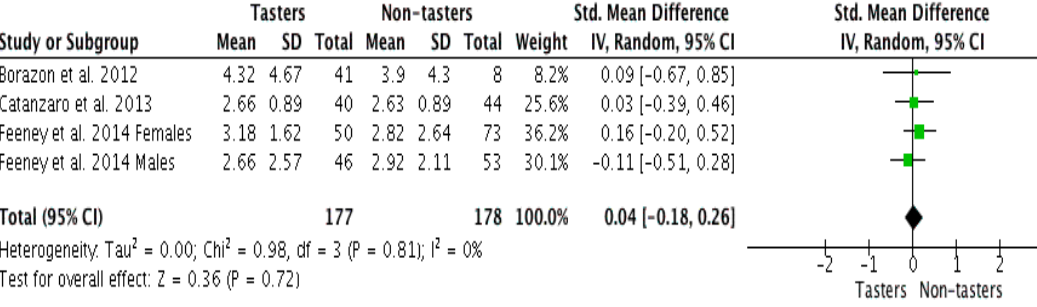
Figure 2. Pooled estimate of bitter-taste vegetable preference between tasters and non-tasters.